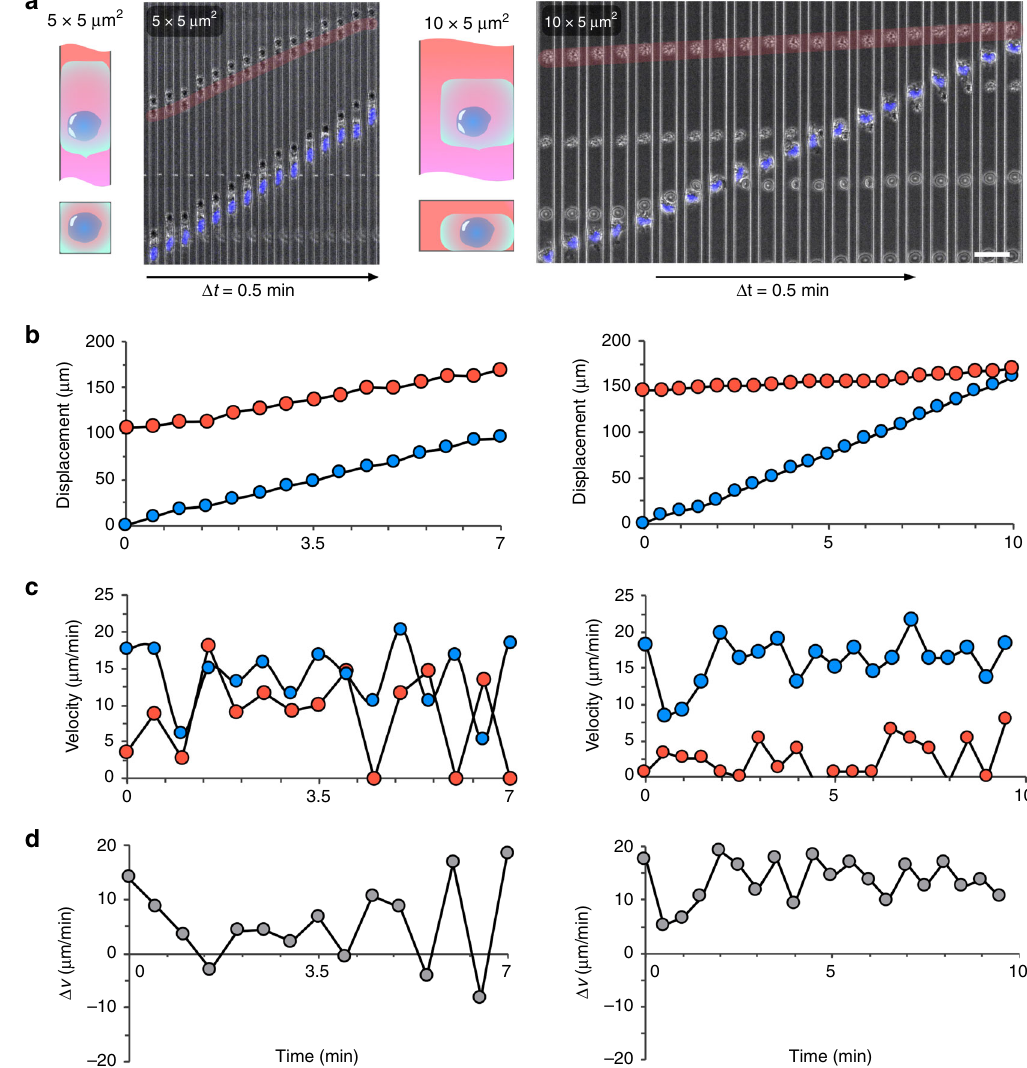
Fig. 4 Neutrophils transiently alter the hydraulic resistance in small channels. a Bright- fi eld microscopic time-lapse images showing the relative positions of migrating neutrophils and distant RBCs in 5 × 5 µ m 2 and 10 × 5 µ m 2 microchannels. The red transparent solid line indicates the trajectories of RBCs. The blue lines represent the neutrophils stained with Hoechst and pseudocolored blue. The scale bar is 20 µ m. The time interval between two frames of images is 30 s. b Displacements over time for representative neutrophil – RBC pairs in 5 × 5 µ m 2 (left) and 10 × 5 µ m 2 (right) channels. c Velocity over time in the 5 × 5 µ m 2 (left) and 10 × 5 µ m 2 (right) channels. d The velocity difference of representative neutrophil – RBC pairs in 5 × 5 µ m 2 (left) and 10 × 5 µ m 2 (right) channels. In panels b and c , the red dots represent the RBCs and the blue dots represent the